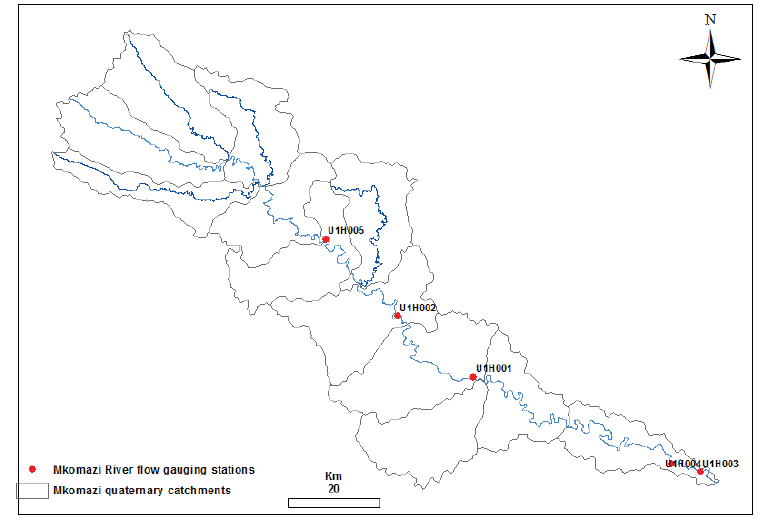
Fig. 5. Location of only Mkomazi River gauging stations (as at 11 November 2016)